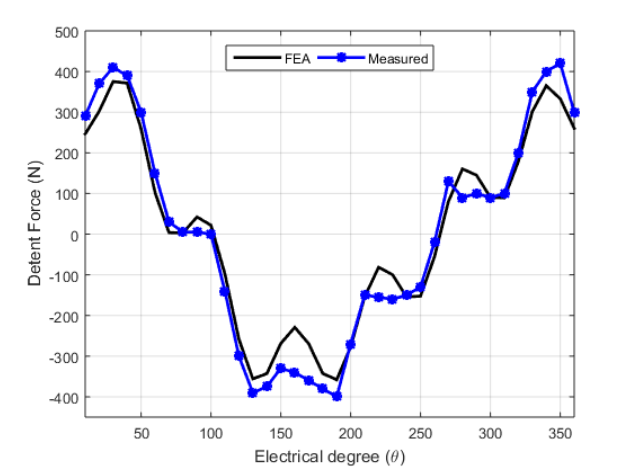
Figure 15. Detent force